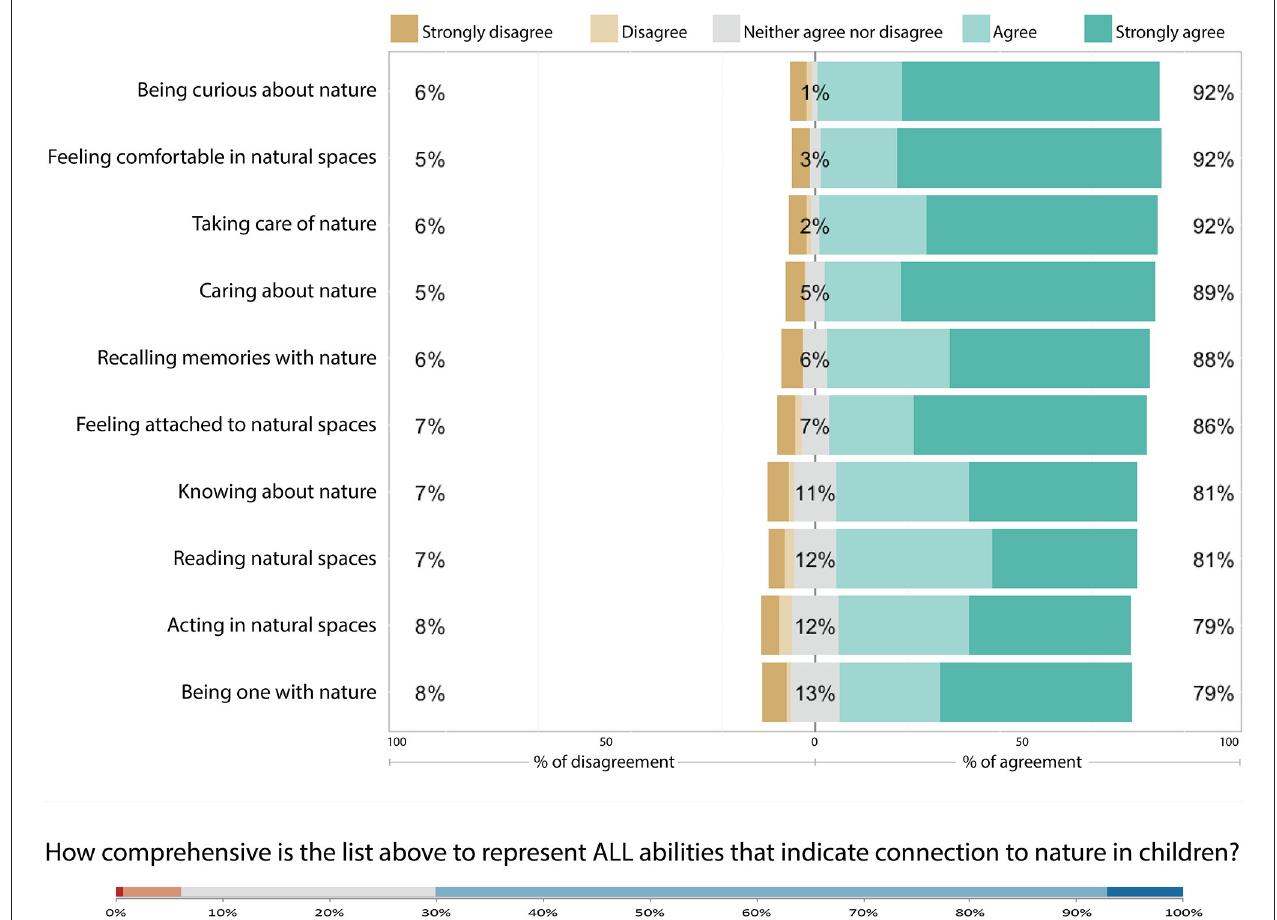
( Figure 6 ). ACHUNAS is composed of the list of qualities of SNS ( Table 1 ); the list of children’s abilities of HNC ( Table 2 ); and three guiding principles (see section Guiding Principles